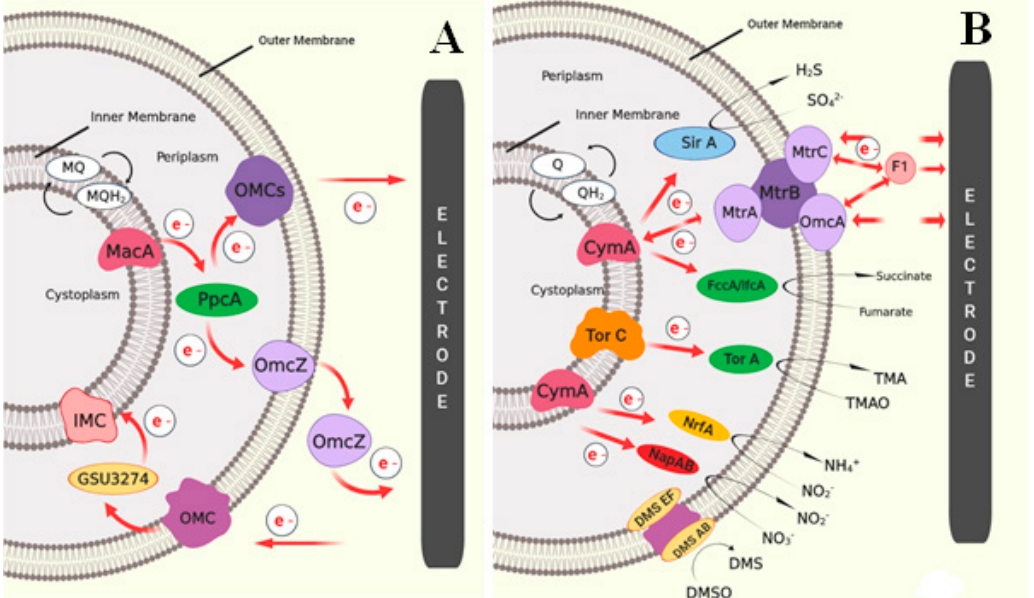
Fig. 2. Schematic image of proposed EET of two metal reducing Gram - negative bacteria in MFCs: ( A ) EET pathway shown by G. sulfurreducens through outer membrane cytochrome ( Omc ) complex, and ( B ) EET pathway shown by S. oneidensis , where electrons are transferred from quinines to CymA or TorC complex then get transferred to MtrABC complex [Sources: Kracke et al ., 2015; Kumar et al .,